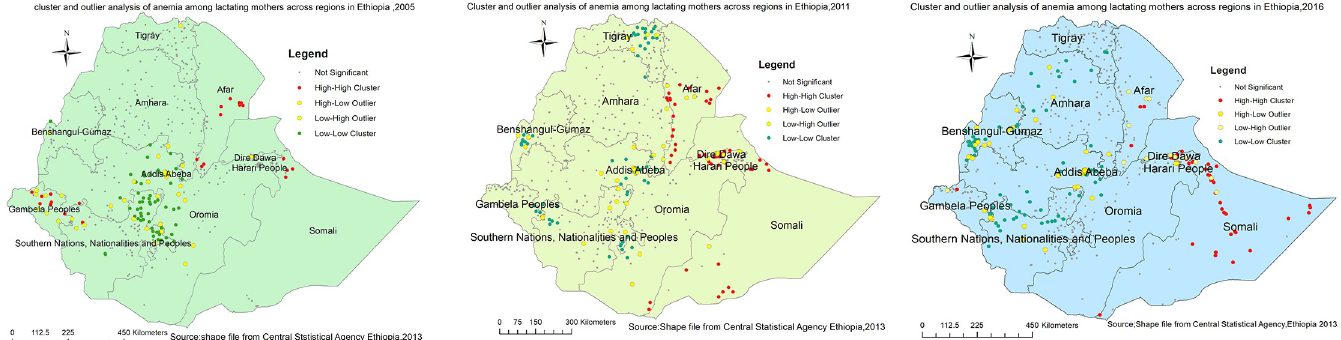
Fig 5. a-c: Cluster outlier identification ofanemia among lactating mothers in Ethiopia, 2005 (a), 2011 (b), 2016 (c) EDHS (Source: Shapefile from Central Statistical Agency, Ethiopia, 2013).